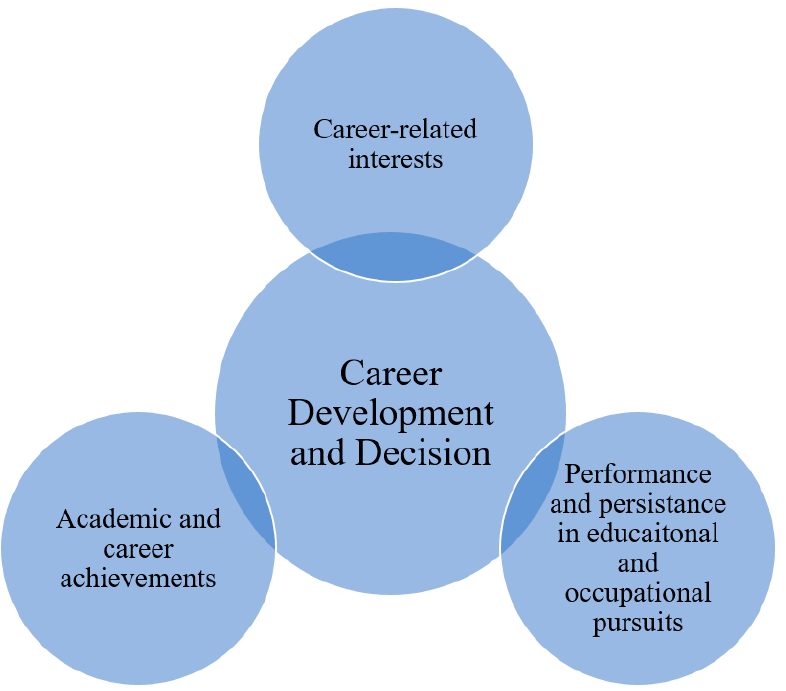
Figure 1. The social cognitive career connections between career development and decision.